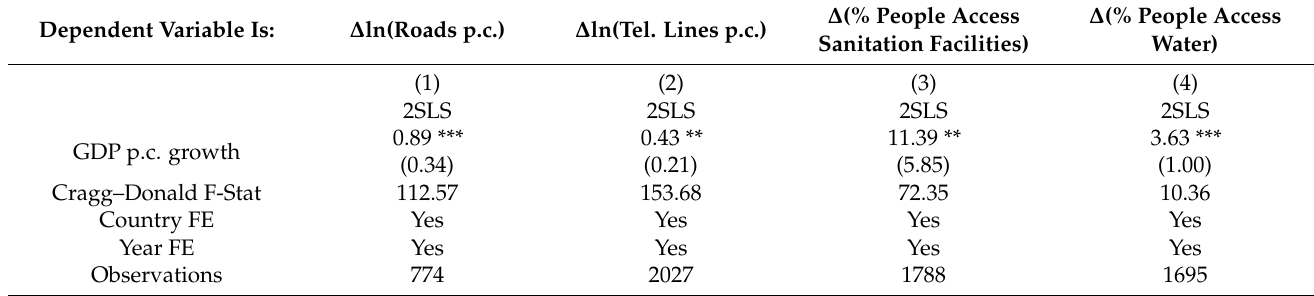
Table 6. GDP growth and infrastructure (using 1970 Net-Export GDP shares of oil to construct the OPS instrument). Dependent Variable Is: ∆ ln(Roads p.c.)